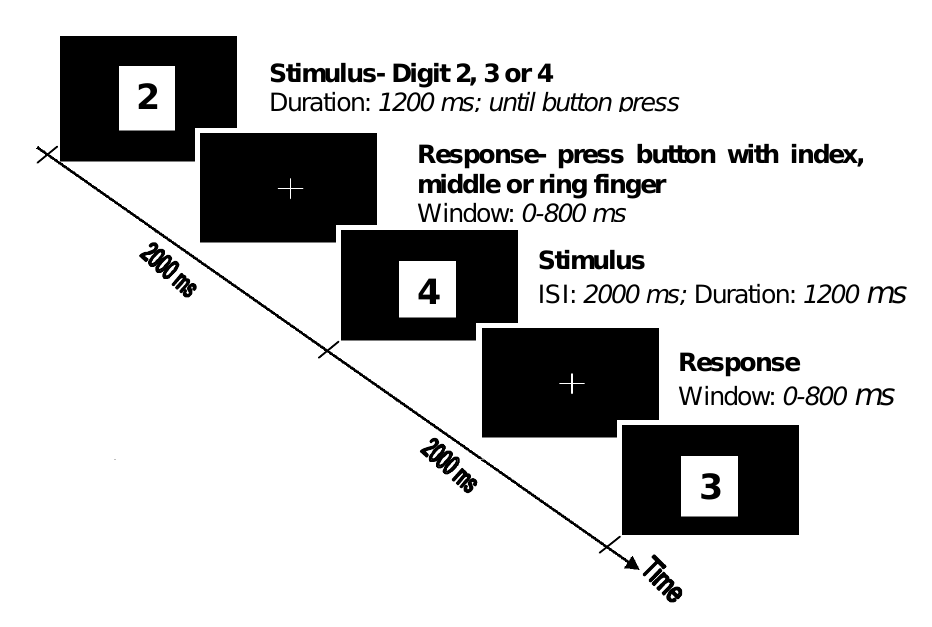
Figure 1. Experimental procedure. Digits 2, 3 or 4 were presented on the center of screen until a button press or automatically disappeared after 1200 ms. Subjects were required to respond by pressing a key with their right hand index finger when “2” appears, the middle finger when “3” appears, and the ring finger when “4” appears. 2000 ms from the last stimulus, a new stimulus comes up. The order of 600 attempts was totally